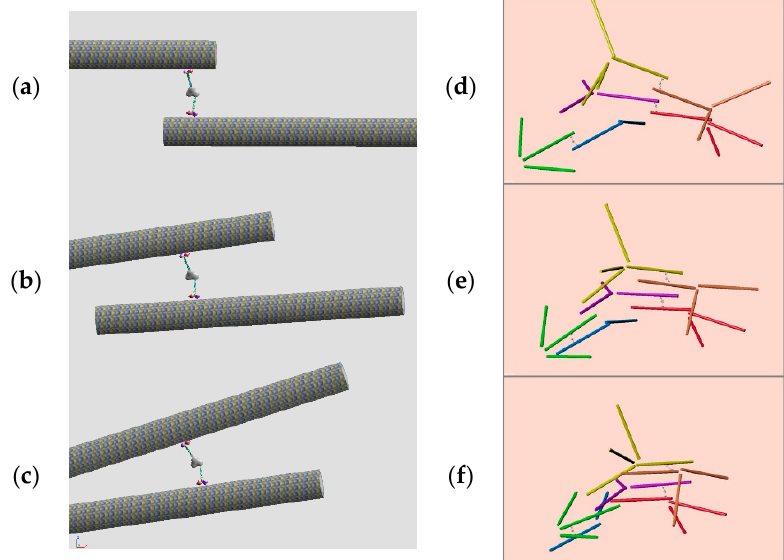
Figure 5. The motility element in the microtubule filaments network: the motion of multimeric kinesin linker on the two microtubule filaments at the three states of a possible contraction motion are depicted for ( a ) starting, ( b ) running, and ( c ) ending. The tentative model with three sets of fragments of microtubule asters. Applying motion to those three states of motion yields the shrinking of the network: ( d ) starting, ( e ) running, and ( f ) ending.